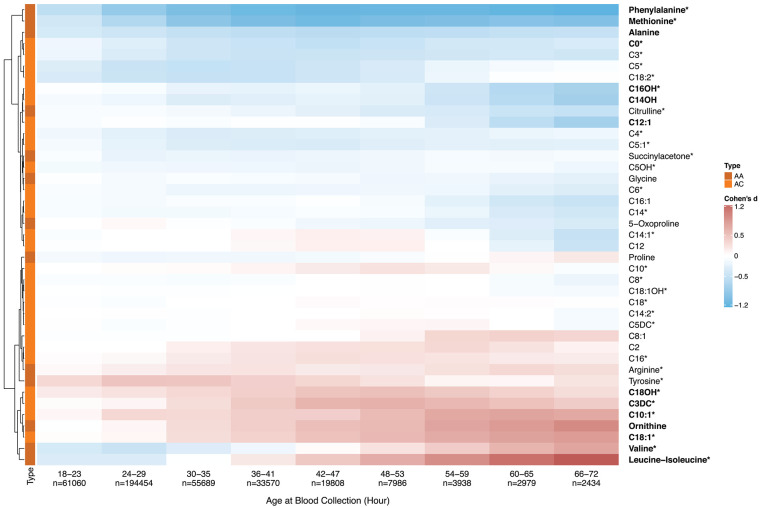
Metabolic analyte levels and age at blood collection. To explore early postnatal metabolic changes, we selected ten infant groups based on AaBC differences with the first group (12–17 h, n = 29,000) being defined as a standard for each metabolite. Effect size differences (Cohen's d) for all 41 metabolites between each of nine AaBC groups (18–72 h) and the standard (12–17 h) was calculated. Positive Cohen's d (in red) indicates elevated metabolite levels, negative Cohen's d (in blue) indicates decreased levels compared to the standard. Hierarchically clustering was used to group metabolites into two cluster of either decreasing (on top) or increasing (at bottom) levels after birth. Thirty four percent of the markers showed significant differences between at least one of the nine AaBC groups and the standard group (Cohen's d ≥ 0.5), including 30 primary NBS markers of metabolic disorders on the RUSP (18) (labeled with*). AA, amino acid; AC, acylcarnitine.